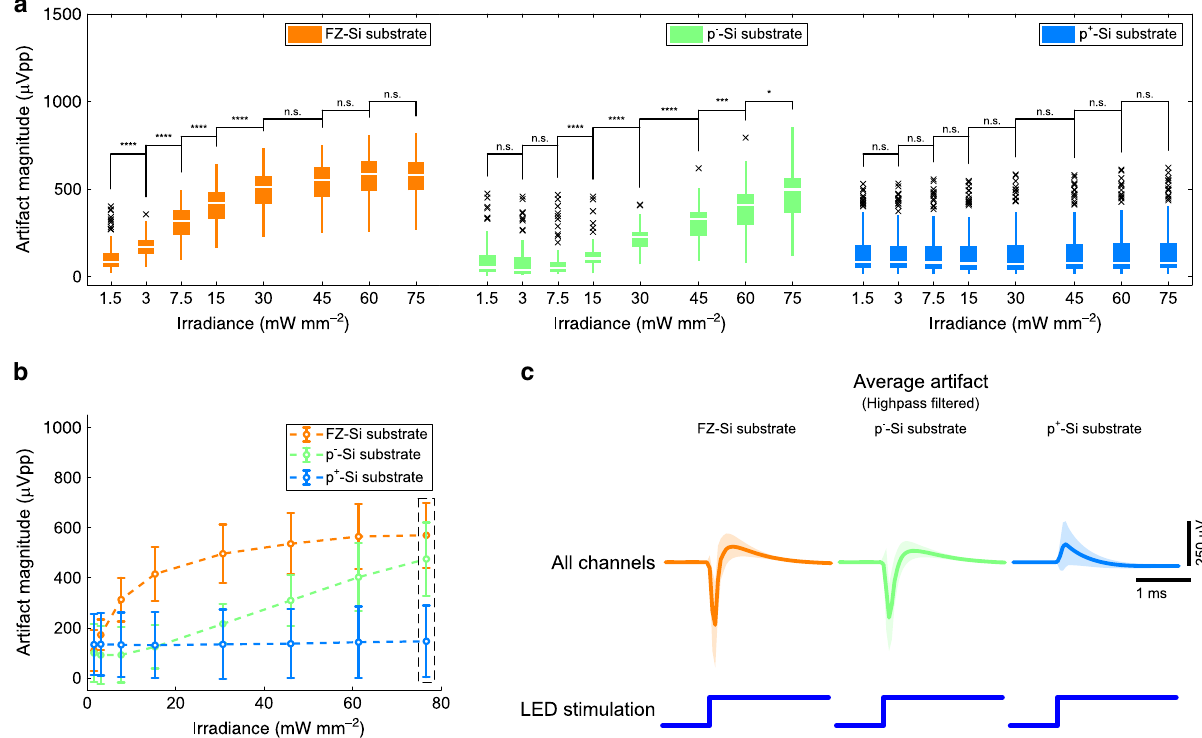
Fig. 3 Eliminated PV-induced artifact. a Peak-to-peak magnitude of highpass fi ltered stimulation artifact recorded on shielded μ LED optoelectrodes with different substrate doping densities. Data from channels corresponding to all electrodes on the shank on which an LED was turned on are plotted. Boxes indicate interquartile ranges, white lines medians, whiskers non-outlier extreme values, and black x marks outliers. b Comparison of the mean peak-to-peak magnitude of highpass fi ltered stimulation artifact whose distribution is shown in part a . Circles indicate the mean, and the error bars indicate one standard deviation. c Mean highpass fi ltered waveforms whose mean peak-to-peak magnitudes are shown in part b , inside the rectangle with black dashed lines. Shaded regions show one standard deviation away from the mean. The mean (±SD) peak-to-peak magnitudes are 569.33 (±129.00), 474.59 (±146.26), and 146.05 (±143.40) μ Vpp for devices with FZ-Si substrate ( n = 124), p − -Si substrate ( n = 67), and p + -Si substrate ( n = 151), respectively. A detailed description of the samples, statistical tests used, and the results of statistical tests are provided in Supplementary Table